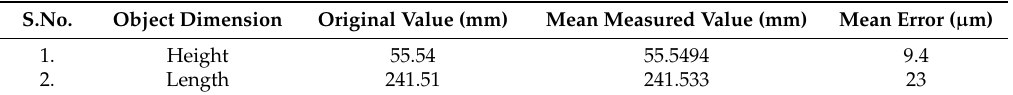
Table 1. Results of the 3D reconstruction of the paper box to demonstrate the accuracy of single view reconstruction.